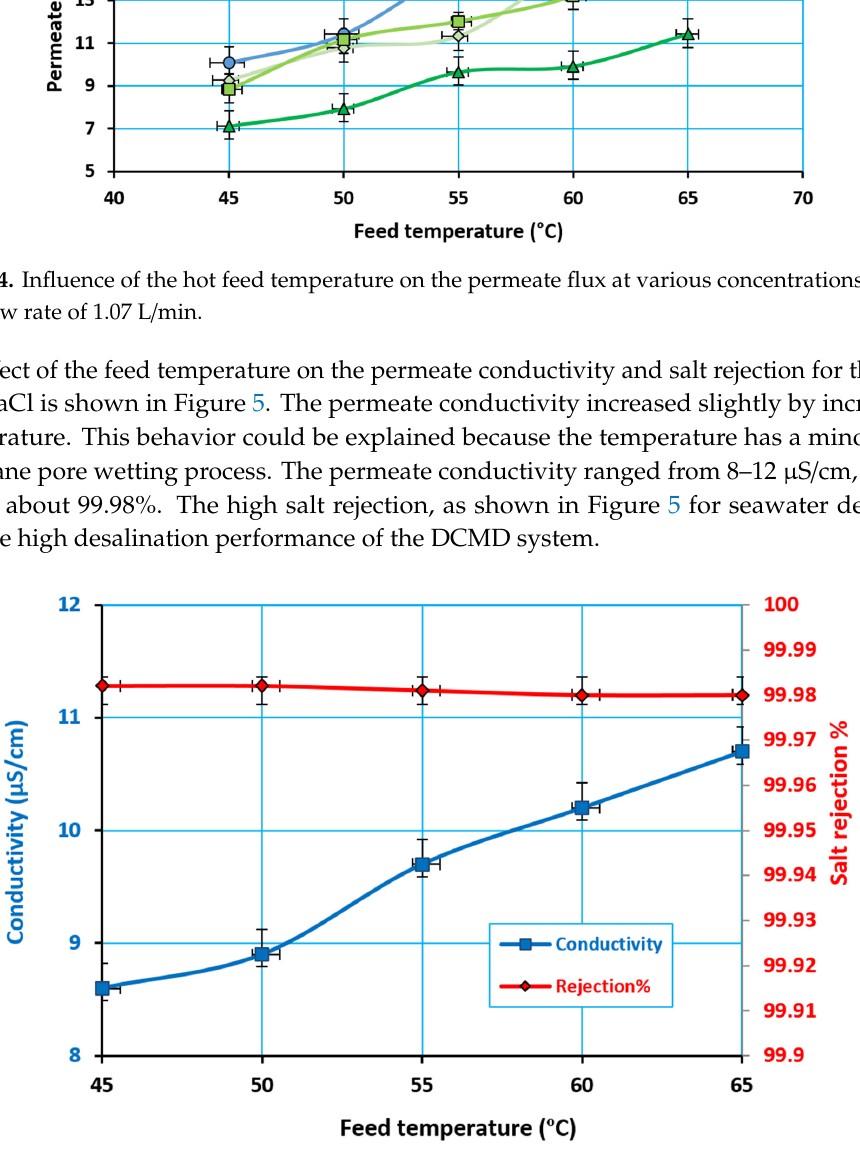
Figure 5. Impact of the feed temperature on the permeate conductivity and the salt rejection for the feed solution of 35 g/L and the feed flow rate of 1.07